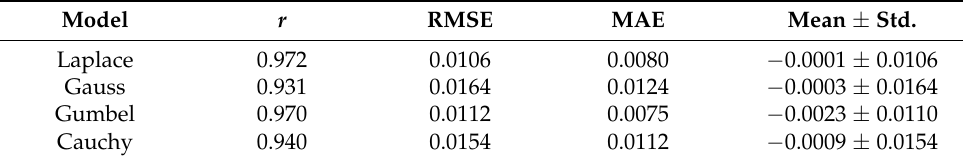
Figure 5. The results of the four combined statistical models vs. the measured values for the albedo during 12 sunny days: ( a ) Laplace, ( b ) Gauss, ( c ) Gumbel, ( d ) Cauchy. Table 5. The correlation coefficients and errors (simulated minus measured albedo) of the four models of albedo within the time range of the solar altitude angle of ≥ 5 ◦ during 12 sunny